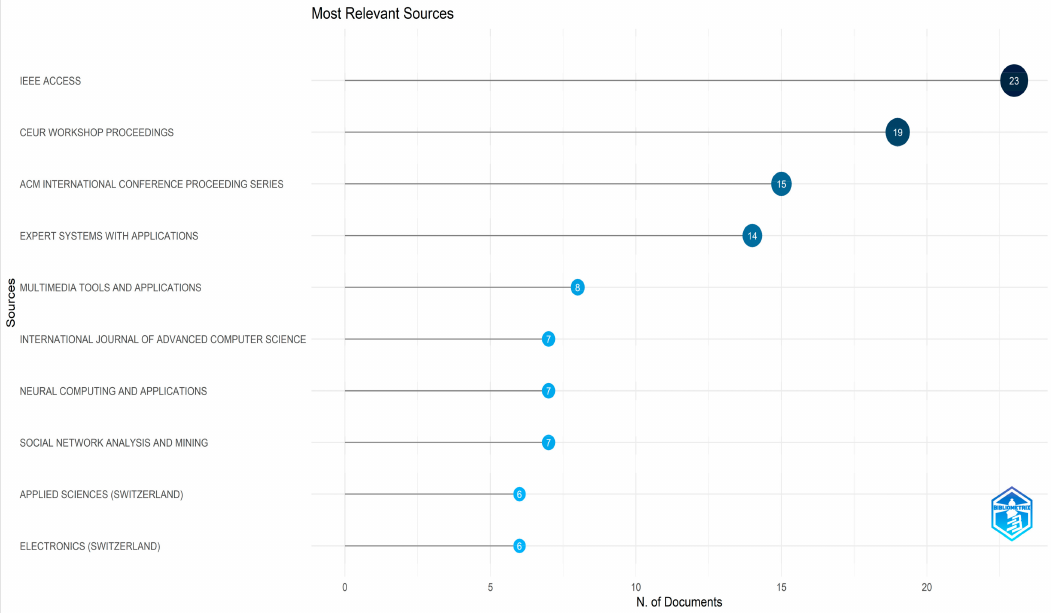
Figure 8. Relevant